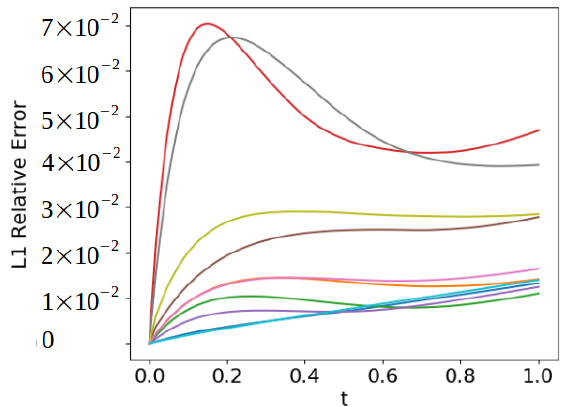
Figure 7. Normalized L 1 error, given by (cid:107) f True − f Pred (cid:107) 1 / (cid:107) f True (cid:107) 1 , shown for 10 different test cases. Time axis is normalized to the maximum time for which training data existed. Error growth is consistently most rapid for t < 0.2. For t > 0.5 error growth is consistently at a much lower rate. It is now of interest to see the effect the error has on the moments of the